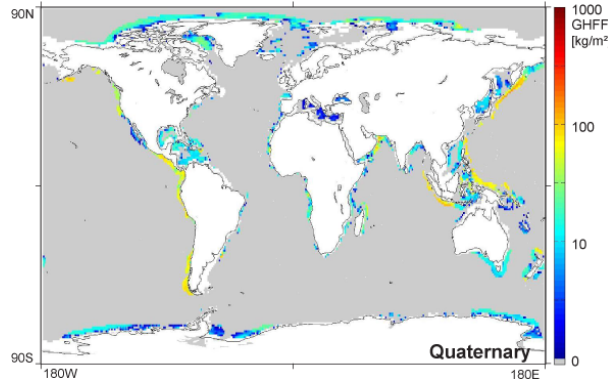
Fig. 9. Distribution map of the total methane hydrate budget consid- ering fluid flow (GH FF ), calculated following Eq. (8), and consider- ing full compaction at passive margins and a fluid flow velocity at active margins of 0.02cmyr − 1